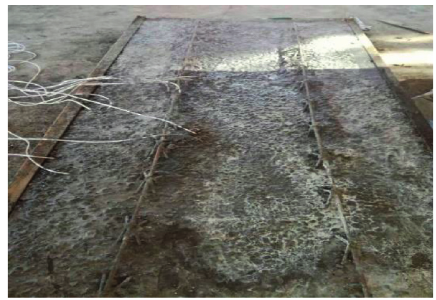
Figure 3: Preparation of LPCSHTHSC base plate.